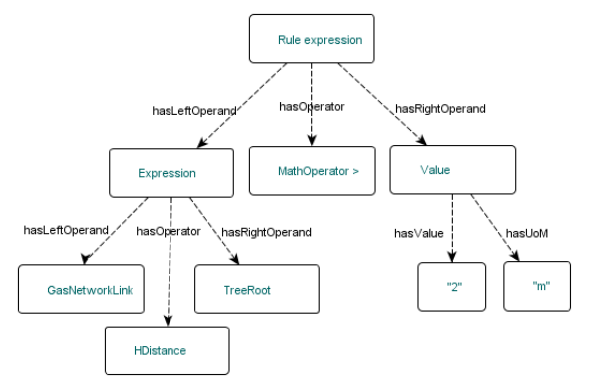
Figure 5. Expression of a specific